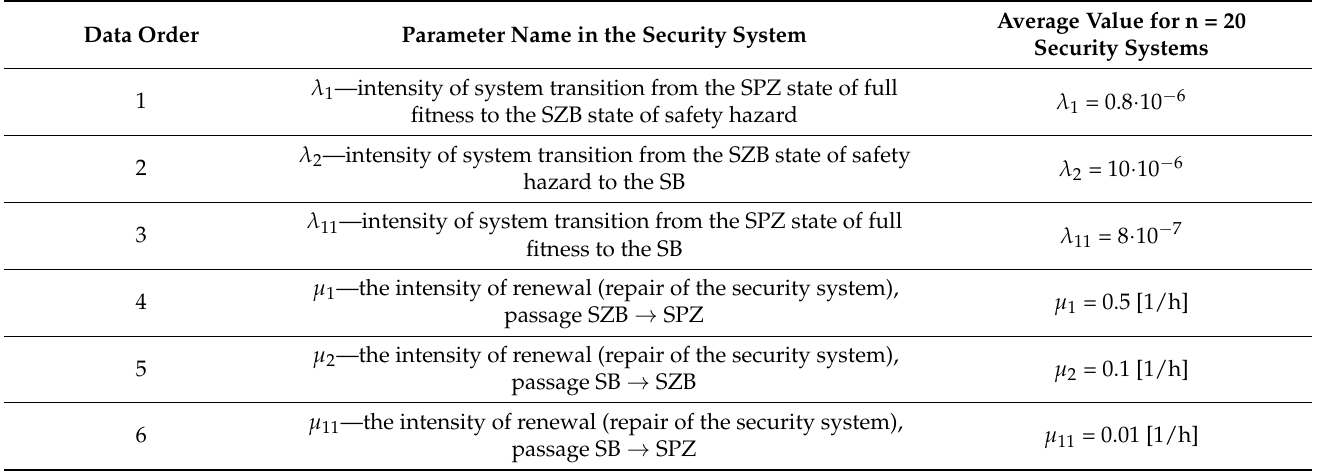
Table 1. ESS operation process data adopted for calculating operation